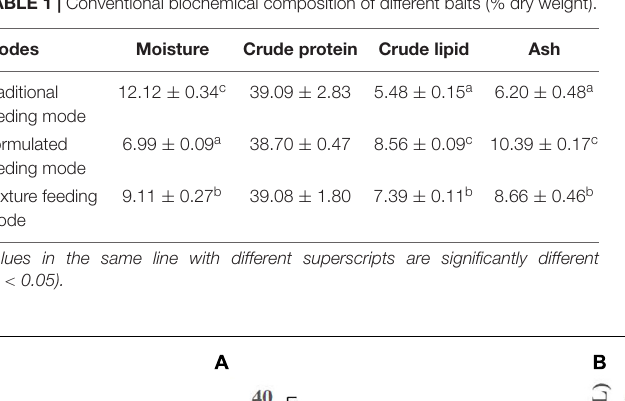
Frontiers in Marine Science |